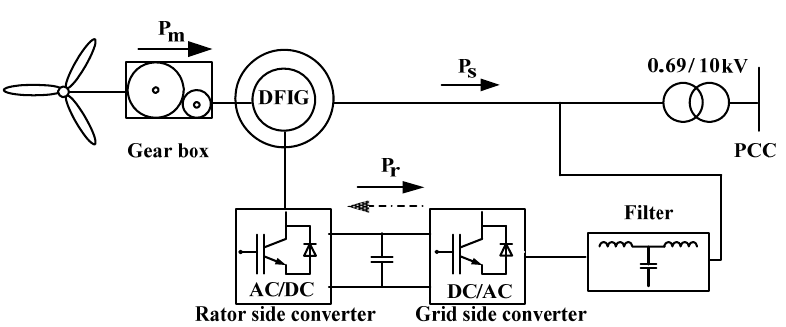
Figure 3. The topological diagram of